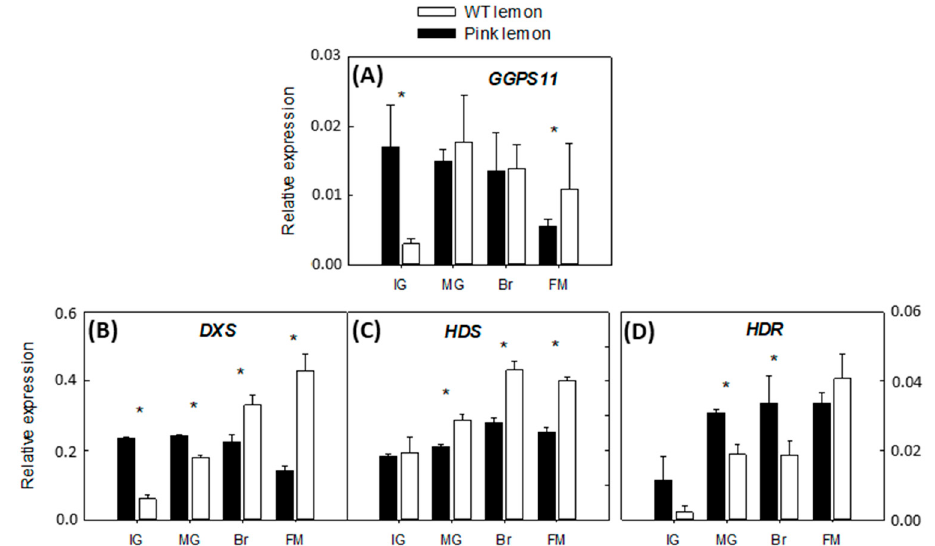
Figure 3. Changes in the expression of genes involved in the MEP pathway: GGPS11 , geranylgeranyl diphosphate synthase 11 ( A ); DXS , 1-deoxy-D-xylulose-5-phosphate synthase ( B ); HDS, hydroxymethylbutenyl diphosphate synthase ( C ); HDR, hydroxymethylbutenyl diphosphate reductase ( D ), in the pulp of the PL and WT lemon fruit at four developmental stages: IG (immature green), MG (mature green), BR (breaker), FM (fully mature). Asterisks indicate significant differences between genotypes for each developmental stage ( p < 0.01) by one-way ANOVA ( p < 0.01).